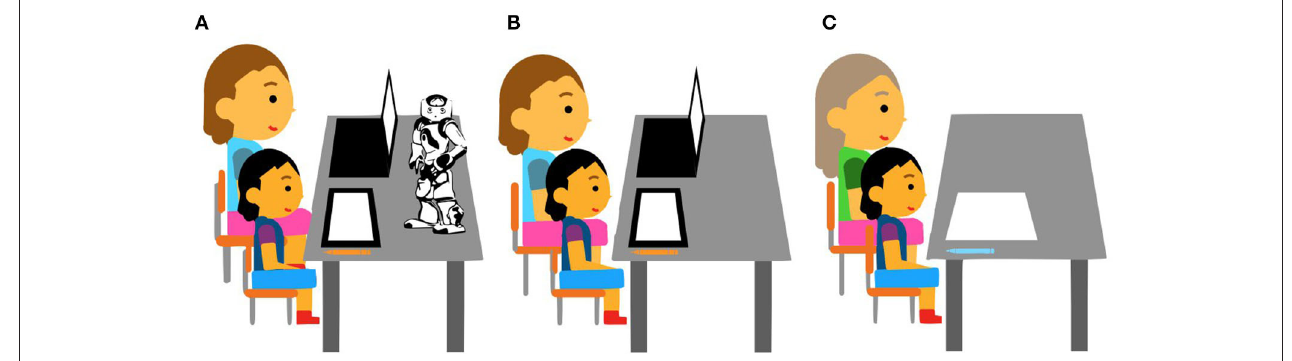
FIGURE 3 | Schematic overview of the setup by conditions: (A) robot + tablet, (B) tablet only, (C) teacher + pen and